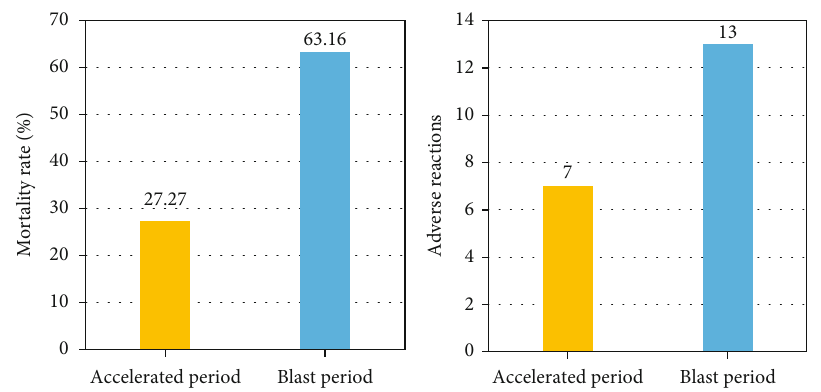
Figure 10: Mortality and adverse e ff ect